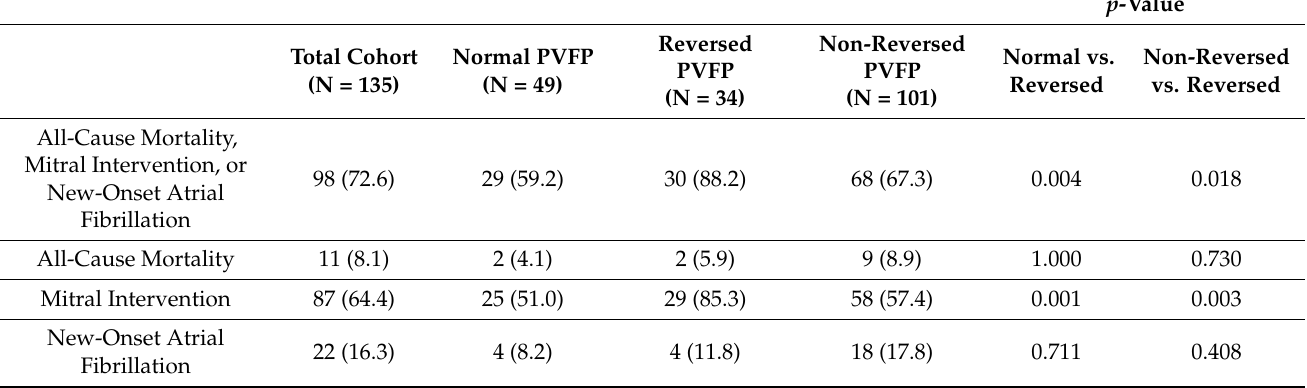
Table 3. Outcomes at 5 Years.